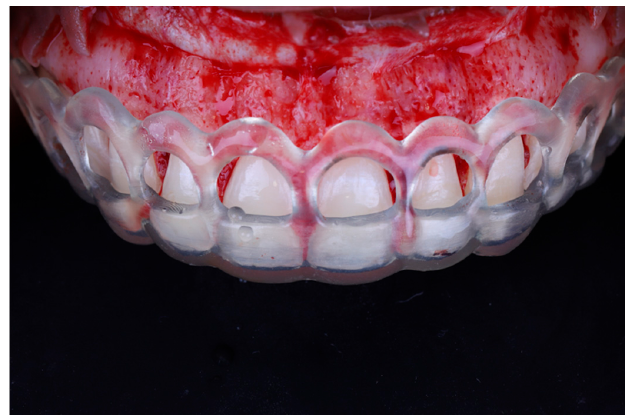
Figure 7. Mucoperiosteal flap elevated.